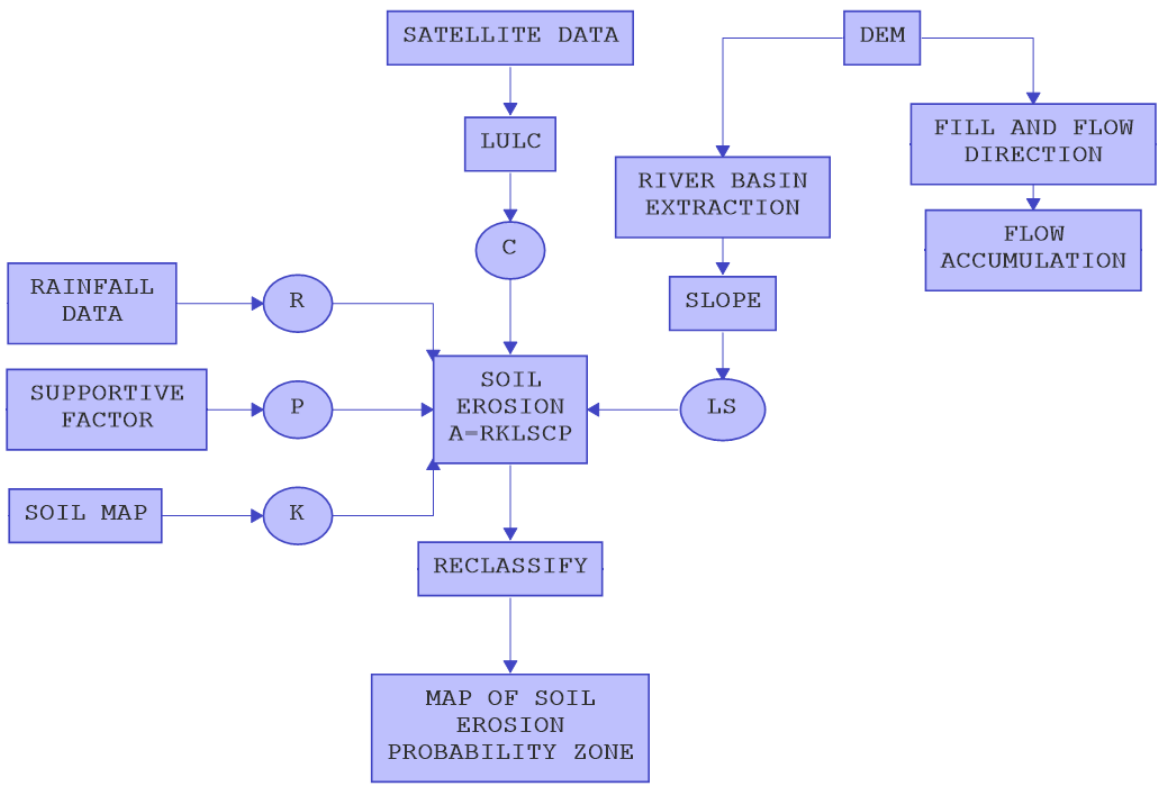
Figure 3. Methodology flowchart of the study.